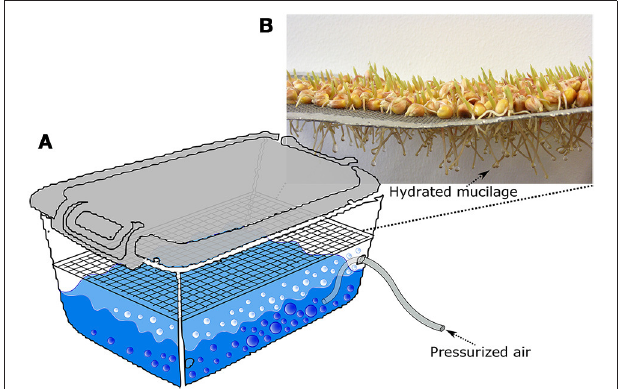
FIGURE 3 | Sketch, describing the procedure of mucilage collection. A tray covered with maize seeds is placed in a closed plastic box. The box is partly filled with deionized water. An aquarium diffuser is placed into the water and pressurized air is pumped through it so that tiny bubbles are produced (A) . Hereby the humidity of the air is increased so that the mucilage stays hydrates and forms small drops around the roots tips (B) . The mucilage drops are once a day with a syringe by applying negative pressure.